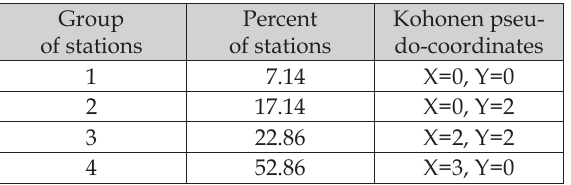
Table 2. Grouping of the first set of 70 stations.